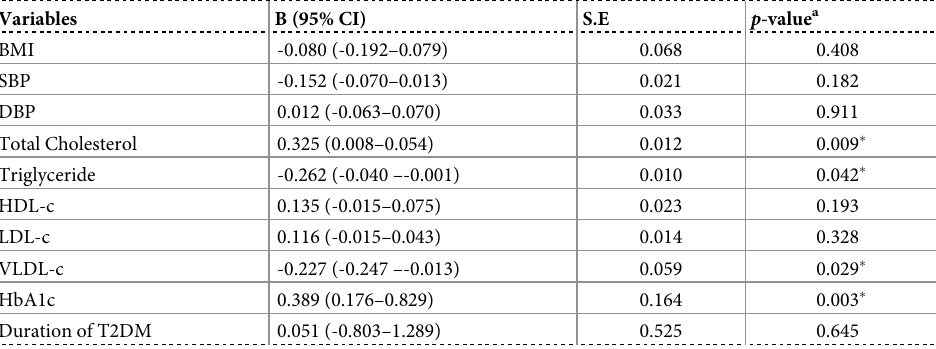
BMI = Body mass index, SBP = Systolic blood pressure, DBP = Diastolic blood pressure, HDL-c = High density lipoprotein cholesterol, LDL-c = Low density lipoprotein cholesterol, VLDL-c = Very low density lipoprotein cholesterol, HbA1c = Glycated Hemoglobin, T2DM = Type 2 Diabetes Mellitus, Β = Regression coefficient, CI = Confidence interval, S. E = Standard error. a p -values were generated by linear regression models. � p -values < 0.05 were considered statistically